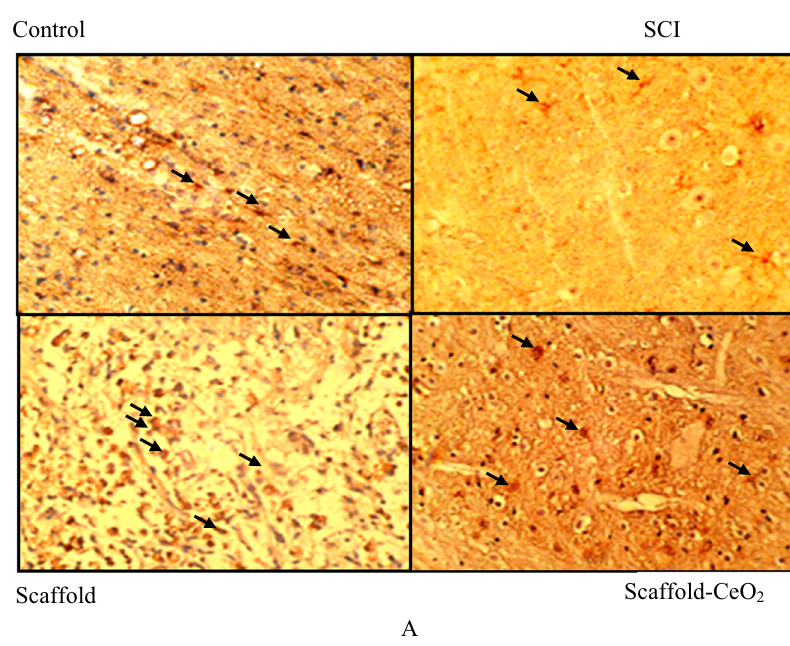
Fig. 5 Effect of SCI and implantation of Scaffold and Scaffold-CeO 2 on expression of Iba-1 in ( A ) Control, Spinal Cord Injury (SCI) group, Scaffold (Sc) group and Scaffold-CeO 2 group. B Quanti fi ed data. Data is presented as mean ± SEM ( n = 3). In each group * p <